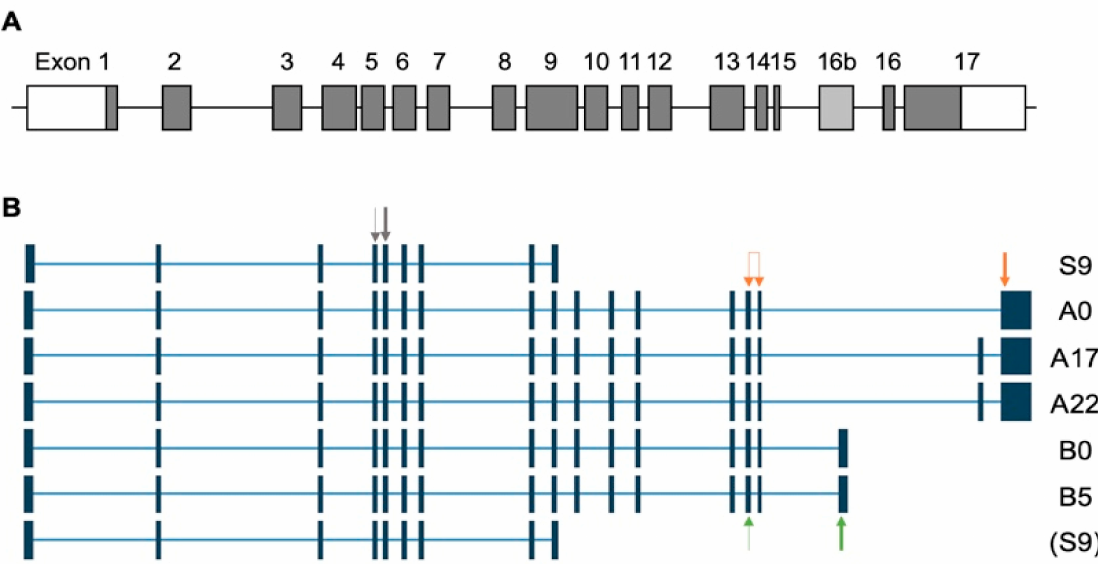
Figure 3. NRP2 gene and NRP2 isoforms/variants observed in the TCGA cohort. ( A ) Genomic organization of the NRP2 gene as identified by Rossignol et al. 2000 [29]. ( B ) NRP2 splice variants observed as determined by the TCGA Splice Variant database (TSVdb). Splice variants are named according to the resulting NRP2 transcript. Two different accession numbers for S9 NRP2 were listed in the TSVdb but only one (top) was expressed in the TCGA BLCA cohort. The primers used for this study are depicted as follows: NRP2: grey arrows; NRP2A: orange arrows (forward primer spans two exons); NRP2B: green arrows. Gene-specific cDNA synthesis was performed with reverse primers (bold arrows),